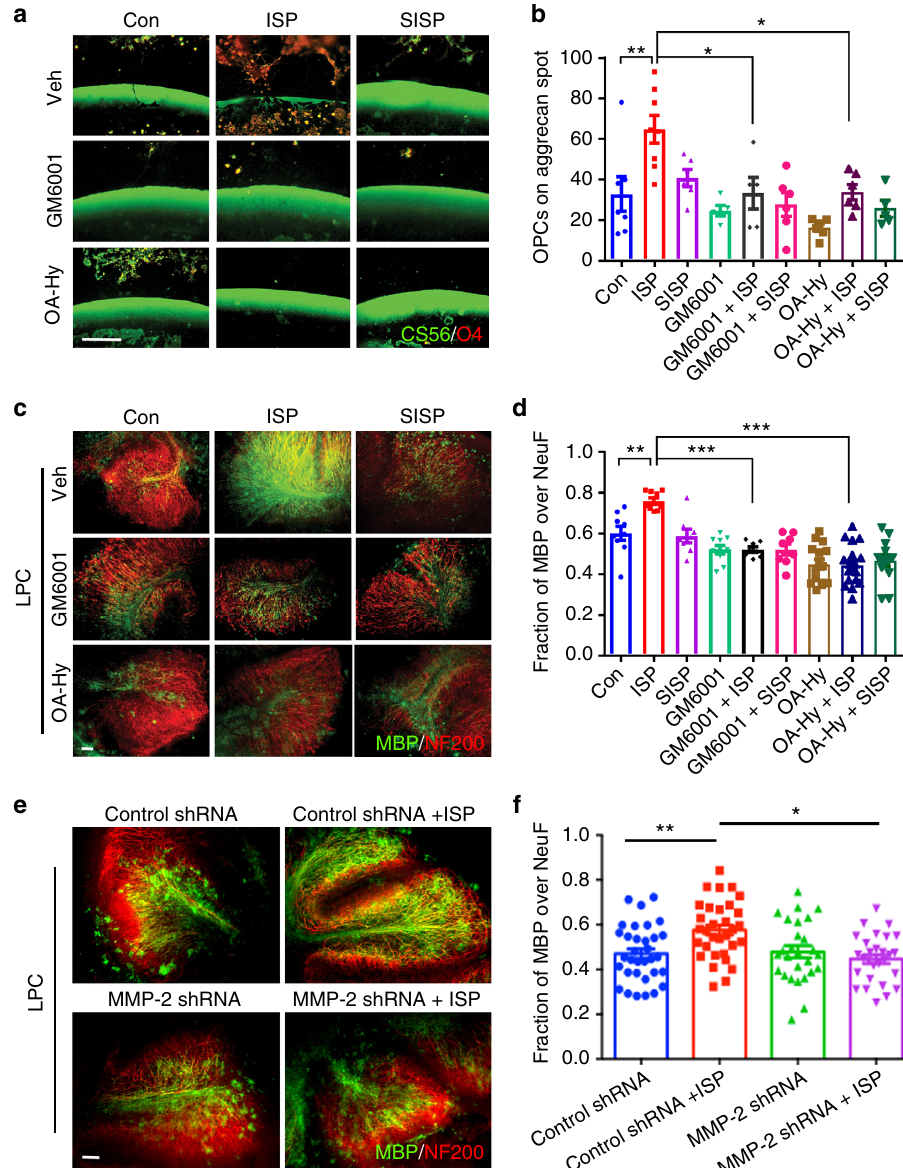
Fig. 7 ISP-induced MMP-2 activity increases OPC migration and remyelination through CSPG degradation. a To ask whether ISP-induced protease activity is involved in OPC migration and remyelination, cultured OPCs were plated onto coverslips with CSPG spot gradients and treated with vehicle control, 2.5 μ M ISP or SISP, 25 μ M GM6001±ISP or SISP, or 100 nM MMP-2 inhibitor (OA-Hy)±ISP or SISP. Scare bar = 100 μ m. b The amount of O4 + OPCs crossing the CSPG barrier was counted and quanti fi ed. ISP treatment ( N = 37 spots, 5 replicates) signi fi cantly induced greater O4 + OPC migration past the CSPG barrier compared to control (One-Way ANOVA, Tukey ’ s posthoc test, P = 0.0002, F(11,48) = 5.013), GM6001 + ISP ( N = 20 spots), or OA-Hy + ISP ( N = 20 spots) treatments. N(Spots) = 31 Control, 26 SISP, 18 GM6001, 20 GM6001 + SISP, 18 OA-Hy, 19 OA-Hy + SISP). c To test whether remyelination was affected by protease inhibition, P7-9 cerebellar slices were all treated with LPC for 18 h, then treated with control vehicle, 2.5 μ M ISP or SISP, 25 μ M GM6001± ISP, or 100 nM OA-Hy±ISP for 9 days before staining for neuro fi lament (NF200) or MBP. Scale bar = 100 μ m. d Remyelination was quanti fi ed through MBP and neuro fi lament colocalization. ISP treatment ( N = 35 images from 4 replicates with up to 13 sections total) signi fi cantly increased MBP- neuro fi lament colocalization over control (One-Way ANOVA, Tukey ’ s posthoc test, P = 0.0001, F (8, 88) = 13.61), GM6001 + ISP ( N = 28), and OA-Hy + ISP ( N = 23) groups. N(images) = 17 Control, 22 SISP, 48 GM6001, 20 GM6001 + SISP, 22 OA-Hy, 22 OA-Hy + SISP. e , f Cerebellar slice cultures were treated with lentiviral constructs for 48 h before LPC treatment. Vehicle or ISP (2.5 μ M) treatment followed for 6 days in vitro. Scale bar = 100 μ m. MBP immuno fl uorescence (green) was then quanti fi ed with NF200 (red) (One-Way ANOVA, Tukey ’ s posthoc test. P = 0.0005. F(3, 116) = 6.395. N = around 30 images from 10 slices). The data are presented as mean ± s.e.m. * P < 0.05, ** P < 0.01, *** p <